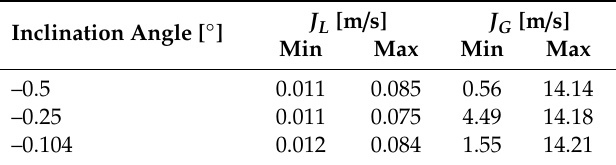
Table 7. Espedal superficial velocity range for inclined tubes